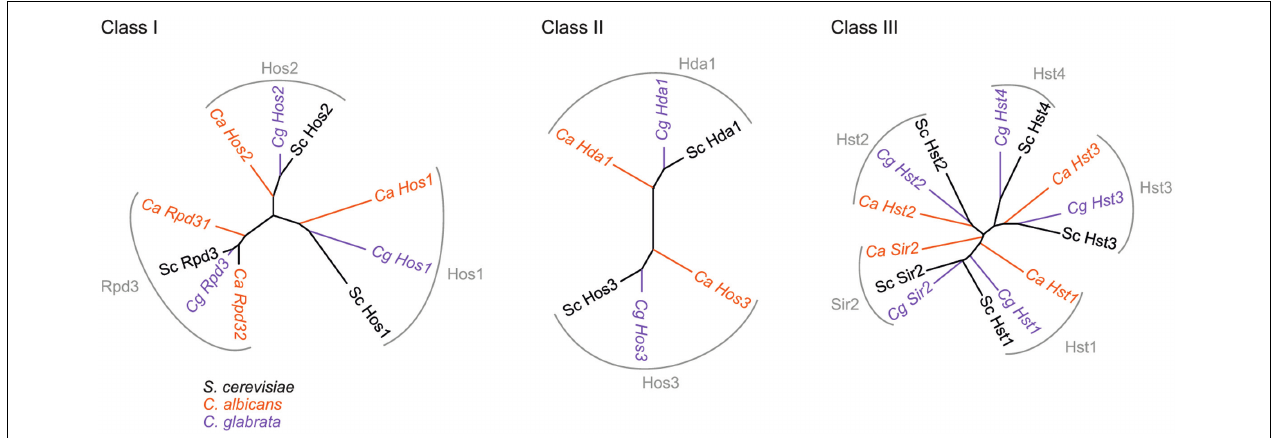
FIGURE 1 | Phylogenetic trees representing HDACs in S. cerevisiae , C. albicans , and C. glabrata . Percent identities matrices between these HDACs are presented in Supplementary Table S1.